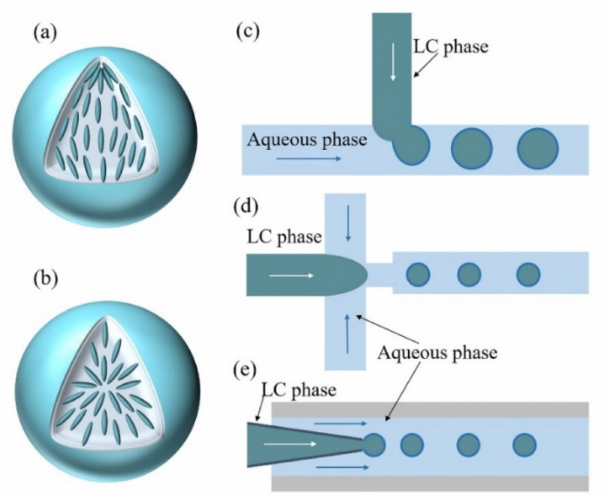
Figure 4. Schematic illustrations of ( a ) bipolar and ( b ) radial configurations of LC droplets. Schematic illustrations of generation of monodisperse LC droplets with ( c ) T-junction, ( d ) flow-focusing and ( e ) co-flow